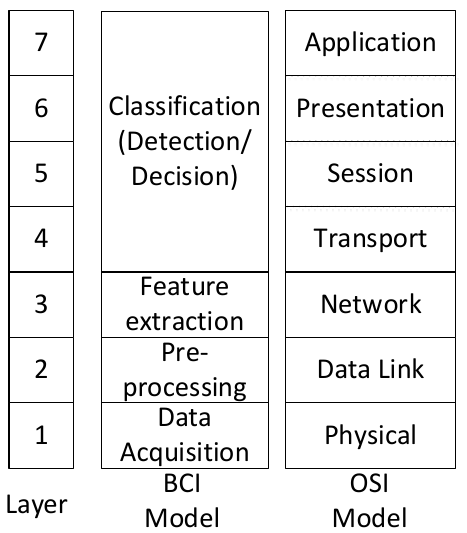
Figure 1. The BCI layer model compared to OSI network model.